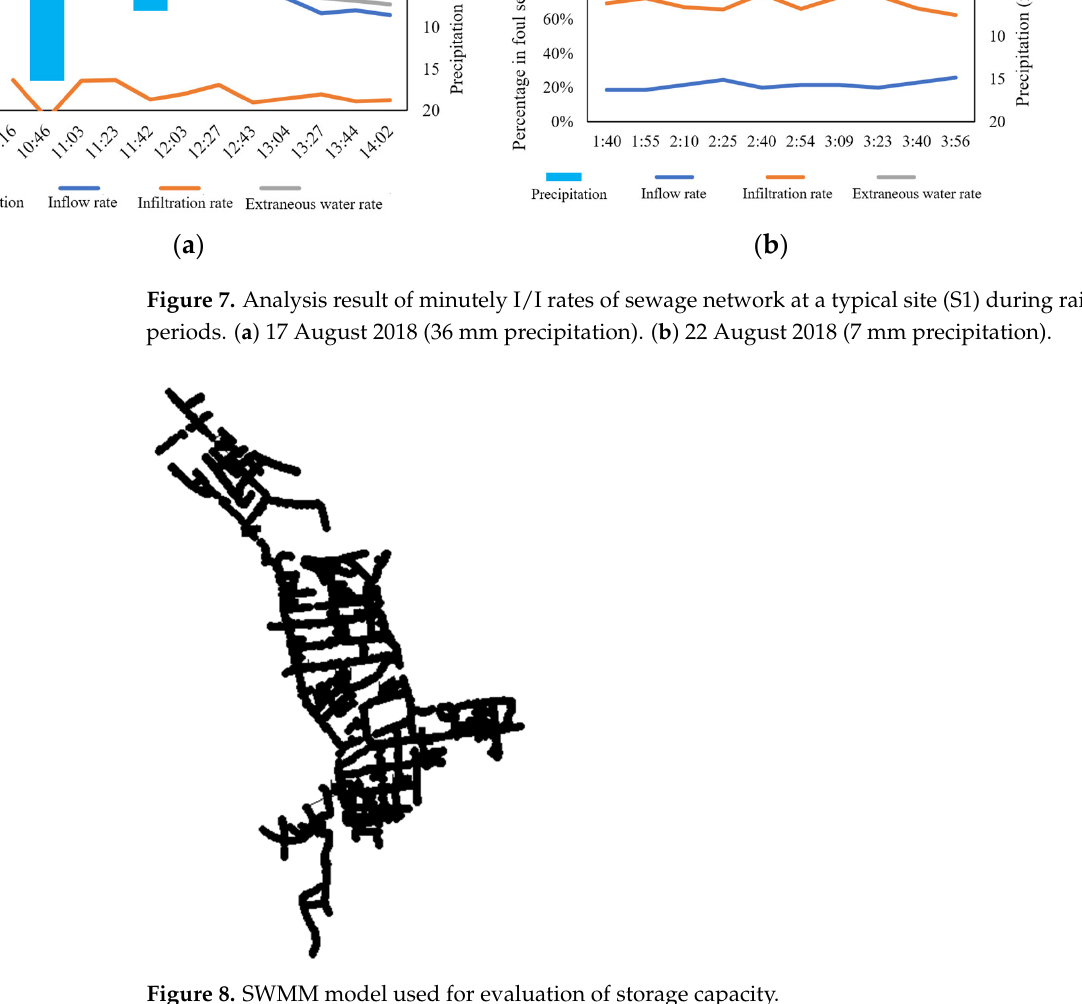
Figure 7. Analysis result of minutely I/I rates of sewage network at a typical site (S1) during rainfall periods. ( a ) 17 August 2018 (36 mm precipitation). ( b ) 22 August 2018 (7 mm precipitation).